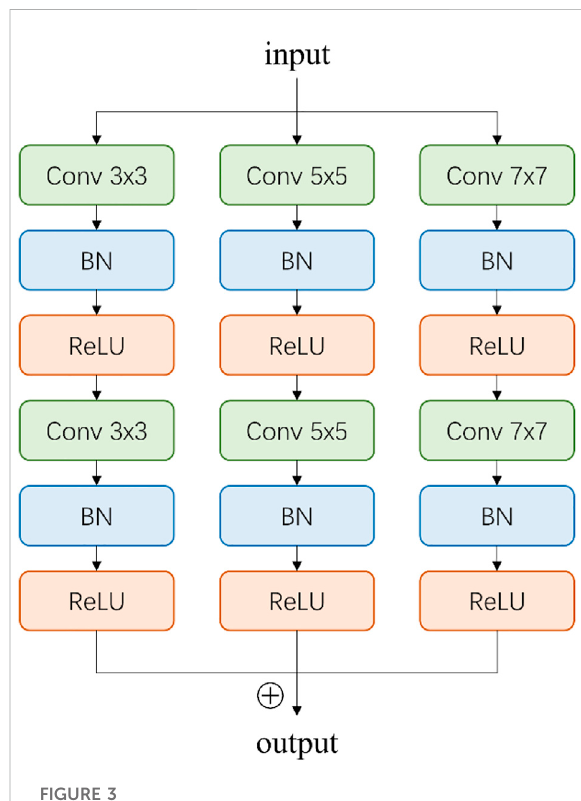
FIGURE 3 Illustration of multi-scale perception block (MSP). The 3 × 3, 5 × 5, and 7 × 7 convolution layers are realized by 3 × 3 dilatation convolution with dilated rate 1, 2, and 3,